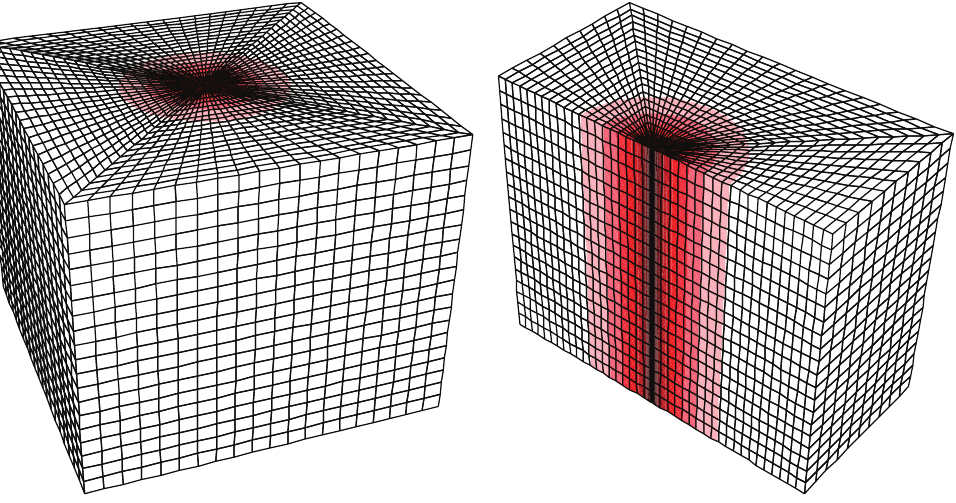
Figure 11: 3D thermal contours.